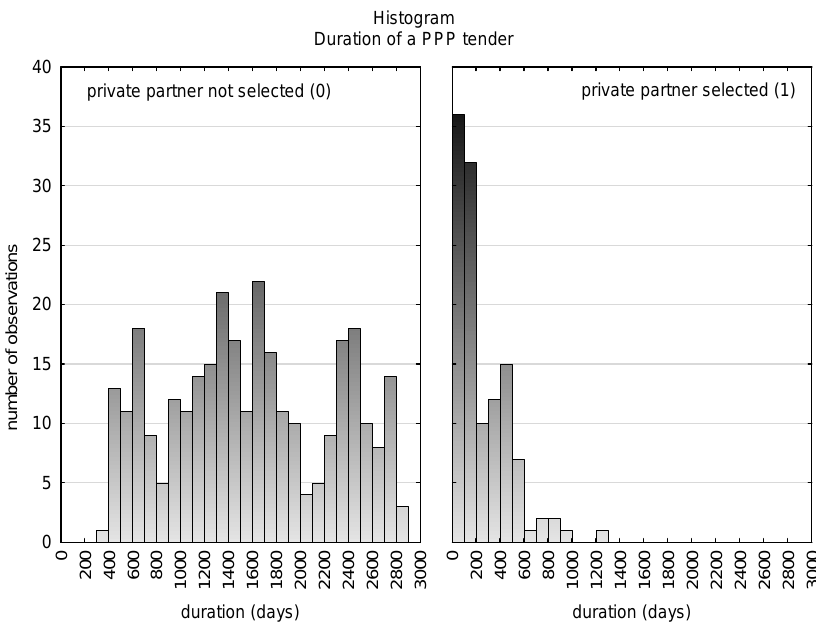
Figure 1. Distribution of the duration of completed and uncompleted observations